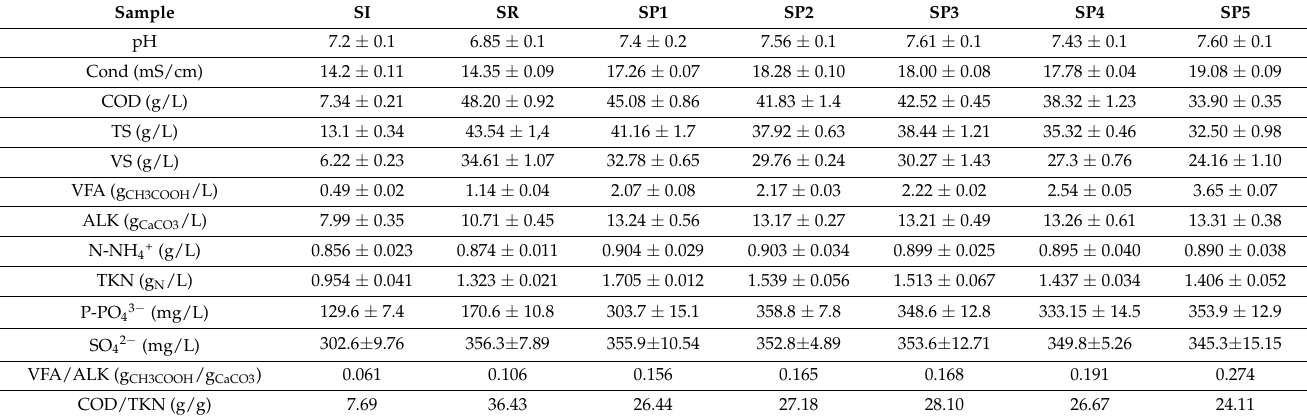
Table 2. Characteristics of samples subjected to BMP tests.